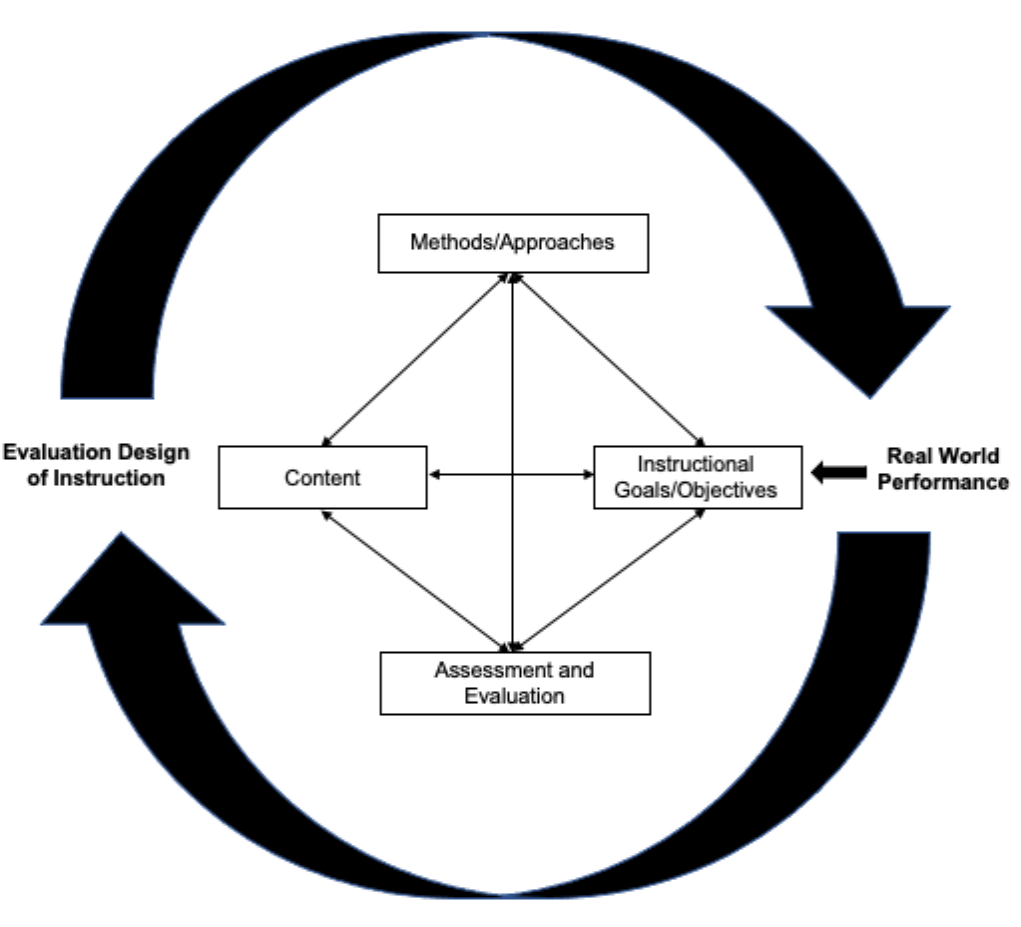
Secret of Instructional